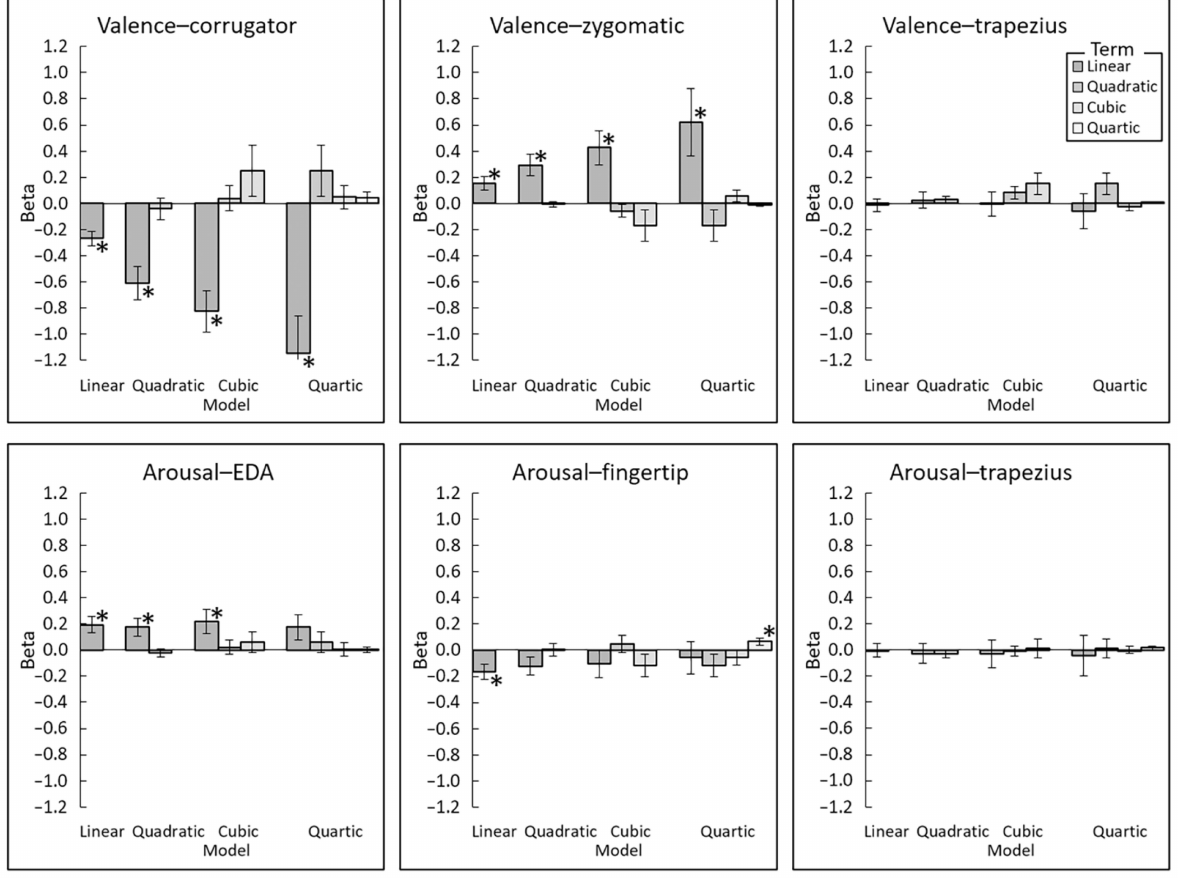
Figure 6. Mean ( ± standard error) parameter estimates of linear, quadratic, cubic, and quartic polynomial regression models of expected subjective–physiological concordance. *, p < 0.05. EDA, electrodermal